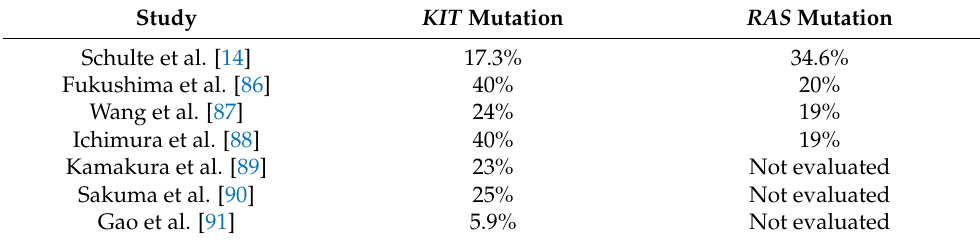
Table 4. Frequency of KIT and RAS mutations in CNS